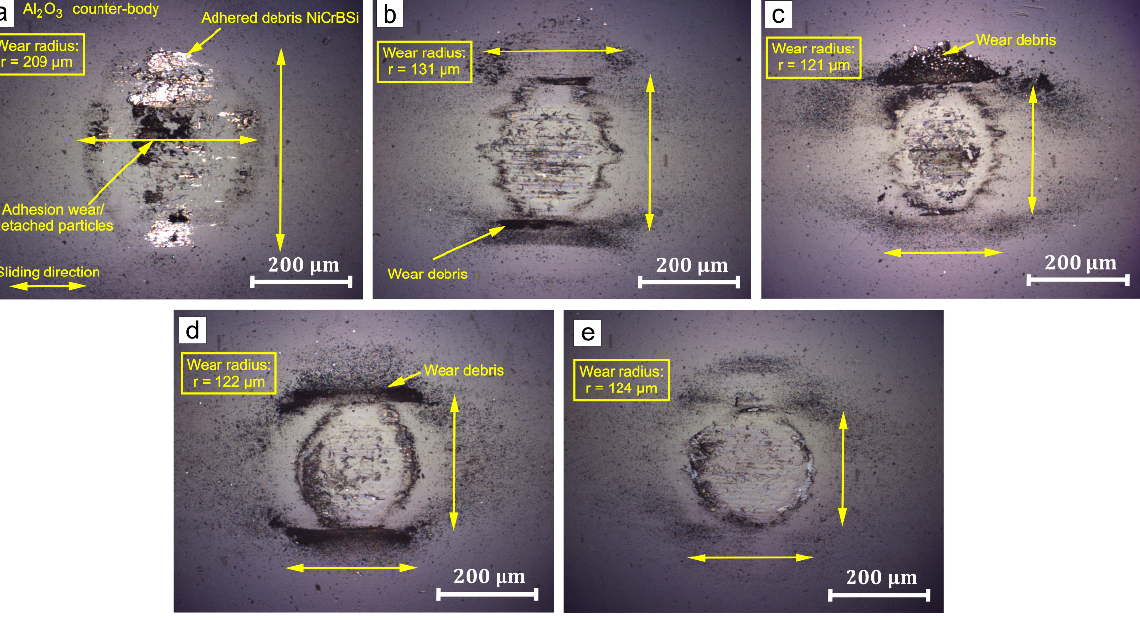
Figure 11. Wear of Al 2 O 3 spherical counter-body on: ( a ) NiCrBSi, ( b ) NiCrBSi + 30 wt.% WC-12Co, ( c ) NiCrBSi + 40 wt.% WC-12Co, ( d ) NiCrBSi + 50 wt.% WC-12Co and ( e ) WC-12Co. The lowest average COF was found for the WC-12Co/Al 2 O 3 pair, with a starting The corresponding wear rate was calculated using an Archard equation [47]: value of 0.12. It increased rapidly to a value of 0.15, and then it slowly increased to 0.17 until 770 cycles were reached. The fine darker wear debris formed, creating three-body abrasion wear. The friction gradually increased after 770 cycles to 0.37 and after 1700 cycles to 0.52. This indicated the gradual formation of rougher micro-asperities on the surface. The friction coefficients in the NiCrBSi + 30, 40, 50 wt.% WC-12Co coatings were also very low (0.15) at the beginning. Then, they increased rapidly with large up-down oscillations within 750 cycles for the 30 wt.% and 40 wt.% WC-12Co cases and 250 cycles for the 50 wt.% WC-12Co, as shown in Figure 10b. In this running-in phase, the combination of adhesive and three-body abrasive wear occurred until the removal of the surface